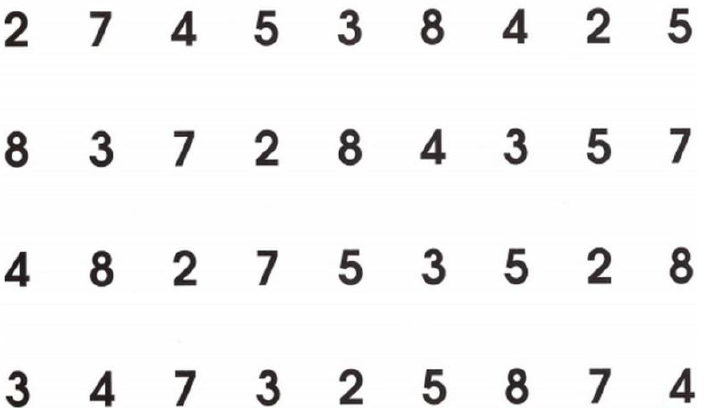
Figure A2. Serial Object Rapid Automatized Naming.